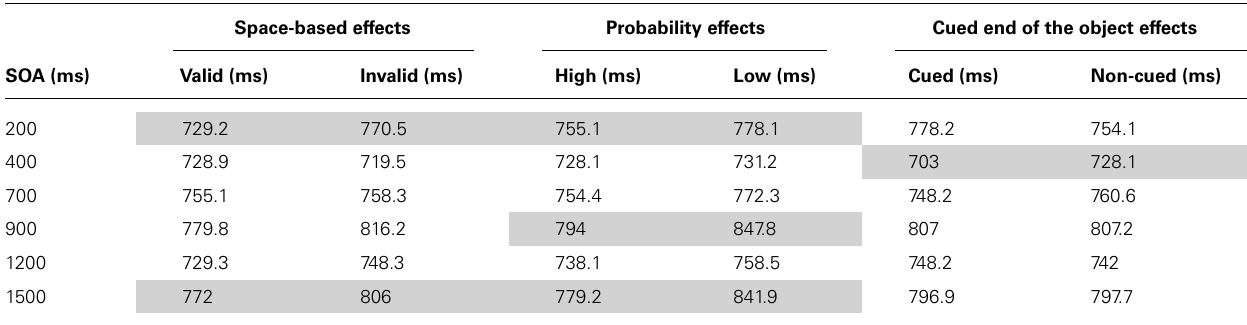
Table 2 | RTs of each comparison for Experiment